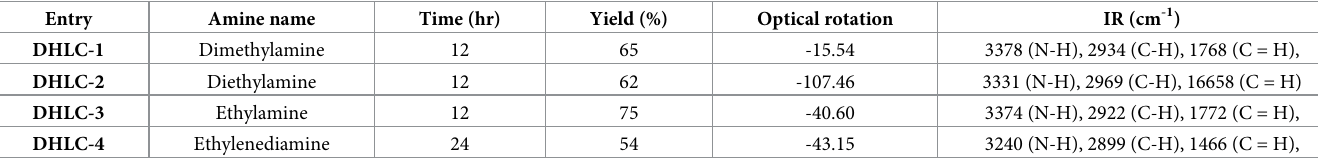
Table 1. Physical properties of 13-amino dehydrocostuslactone